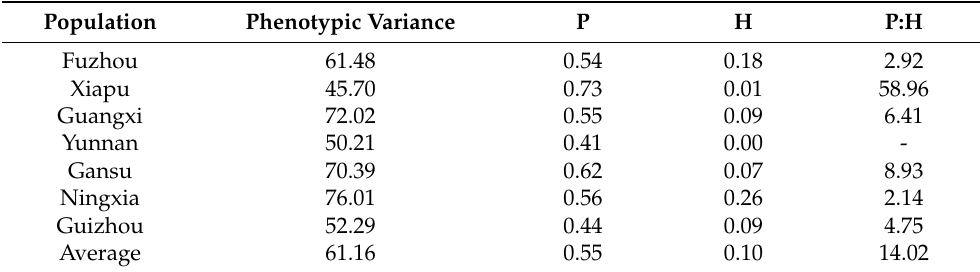
Table 3. Phenotypic variance, heritability (H), and plasticity (P) of aggressiveness in the Phytophthora infestans populations estimated from lesion size at 2–6 days post-inoculation.